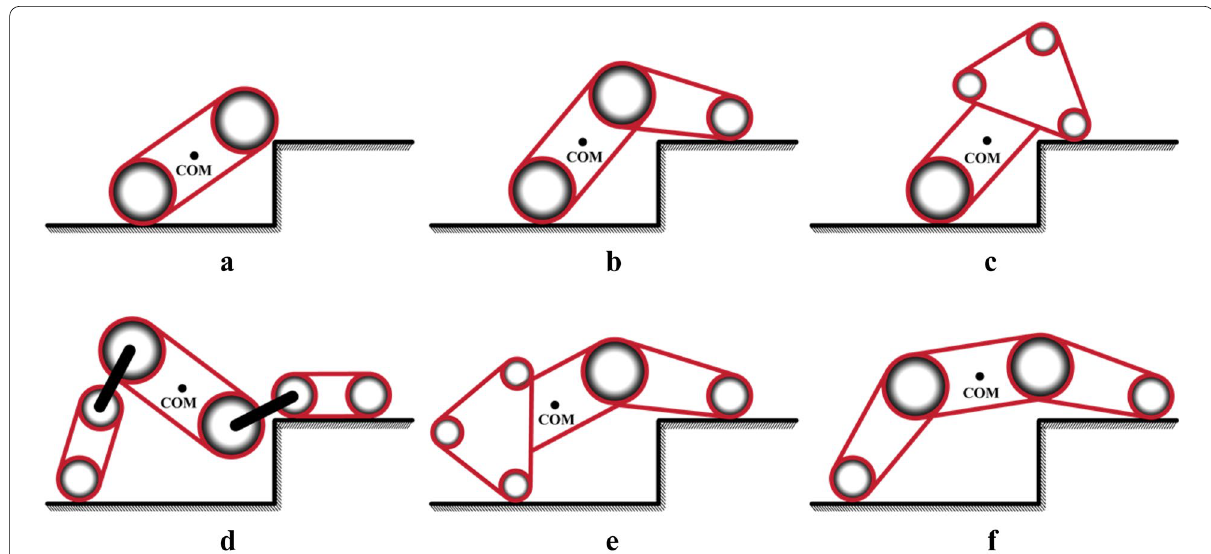
Fig. 4 Step climbing of a response robot with various locomotion mechanisms. a No flippers. b One pair of regular flippers. c One pair of triangular flippers. d Two pairs of two-linkage flippers. e One pair of triangular flippers combined with one pair of regular flippers. f Two pairs of regular